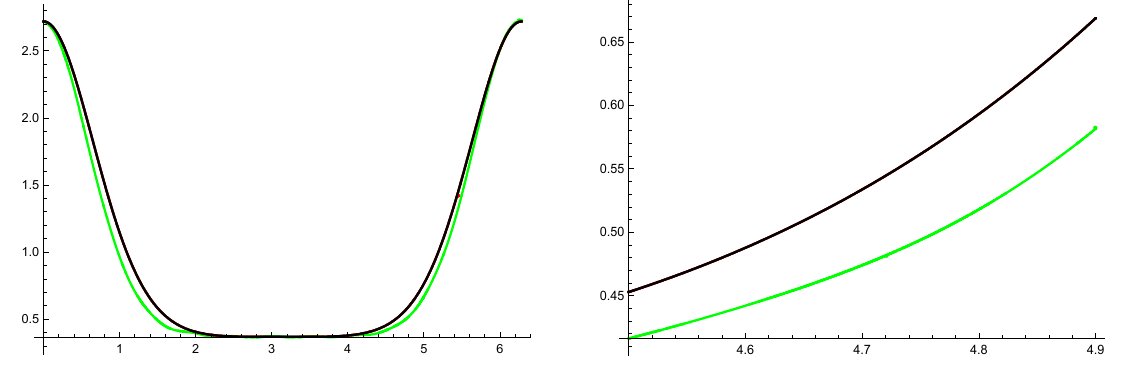
Figure 4. (cid:60) ( F ( z )) , (cid:60) ( L − n , n − 1 ( F , z )) and (cid:60) ( A − n , n − 1 ( F , z )) with F ( z ) = e z , z = e i θ , θ ∈ [ 0,2 π ] , θ ∈ [ 4.5,4.9 ] and n =